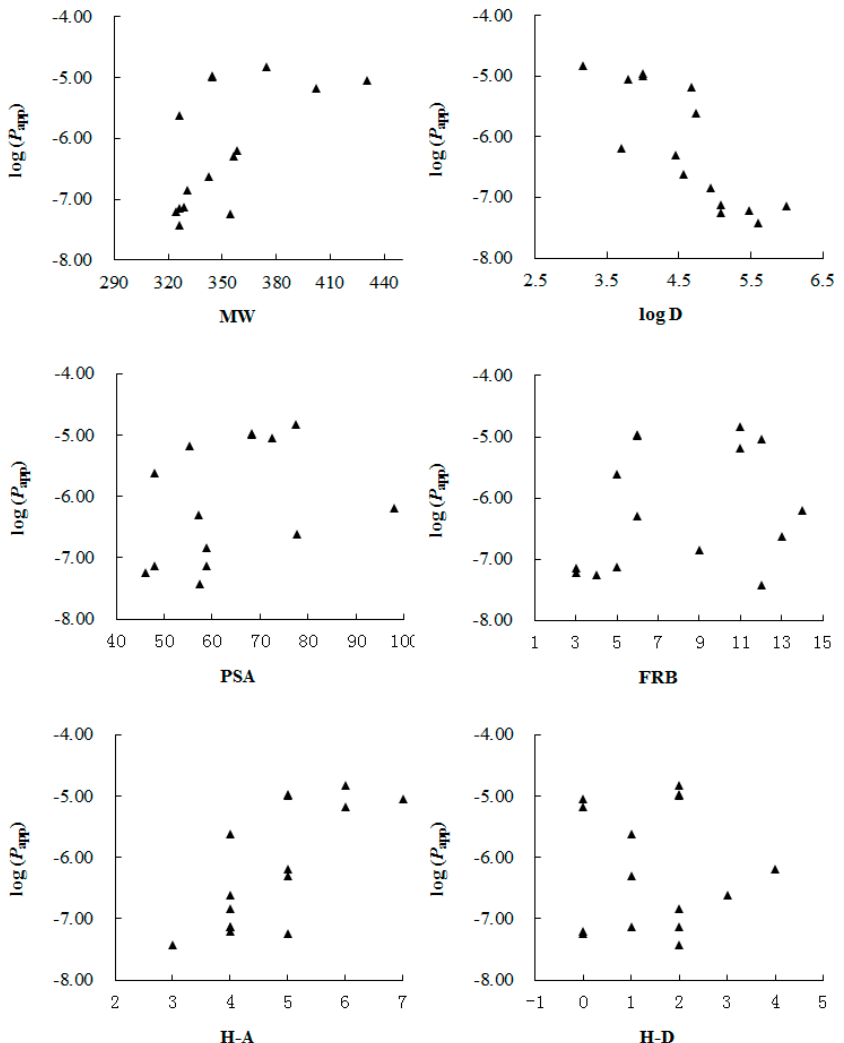
Figure 2. Correlation between log( P app ) values of the test compouds 1 – 15 and their molecular physicochemical properties, including: molecular weight (MW), log D (at pH 7.35), polar surface area (PSA), the number of free rotatable bonds (FRB) and the number of hydrogen bond acceptors (H-A) and donors (H-D), respectively.